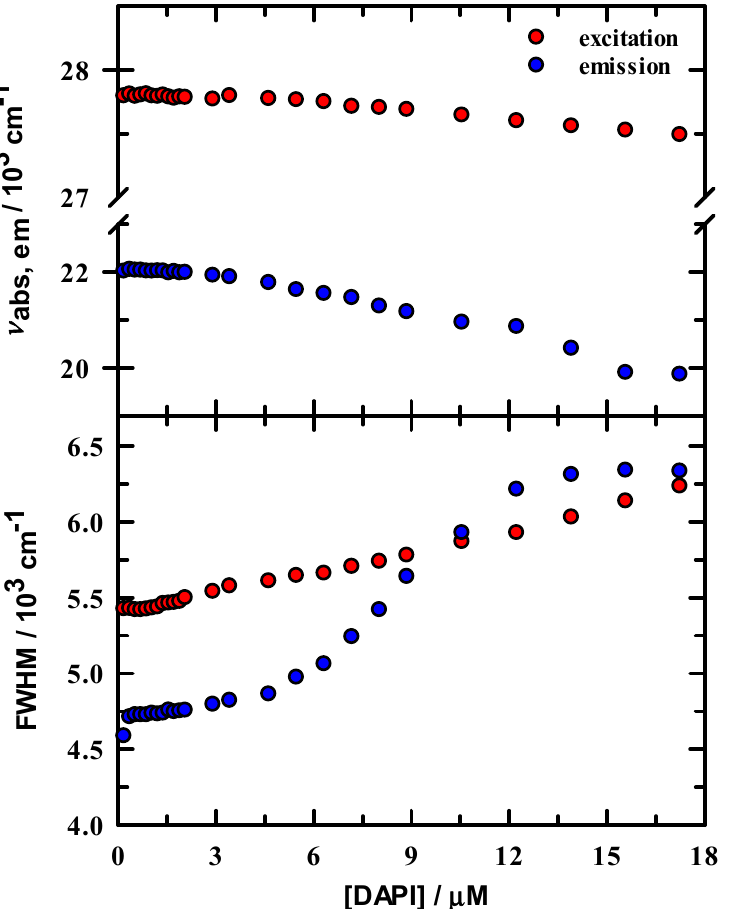
Figure 3. Steady-state spectral parameters for DAPI/DNA duplex in 10 mM tris buffer at pH = 7.0. Upper panel: excitation (red) and emission (blue) peak maxima. Lower panel: excitation and emission full width at half maximum values.